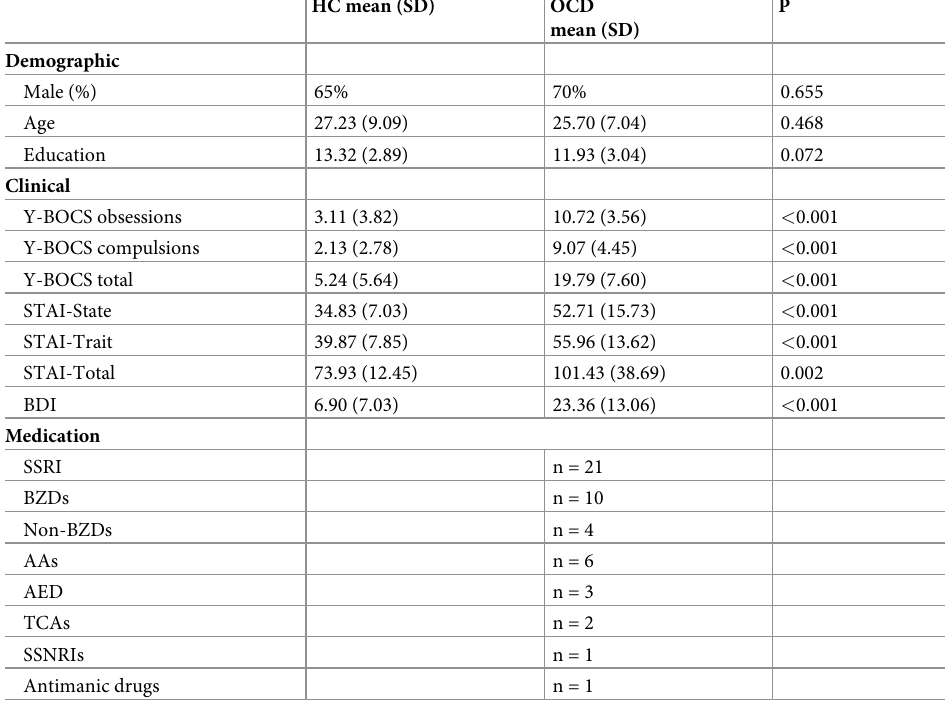
Table 1. Characteristics of the